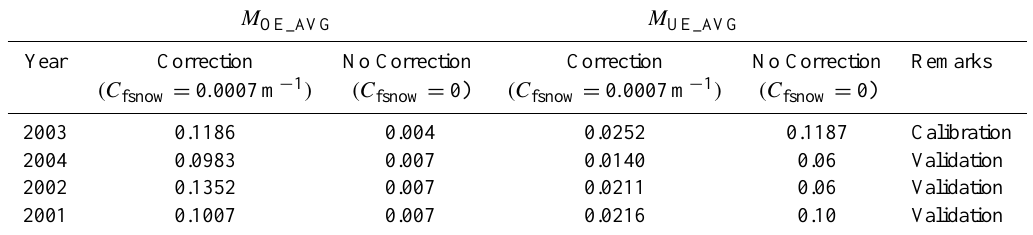
Table 5. Snow covered pixel error components ( M OE_AVG and M UE_AVG ) for calibration and validation periods (after and before correction).